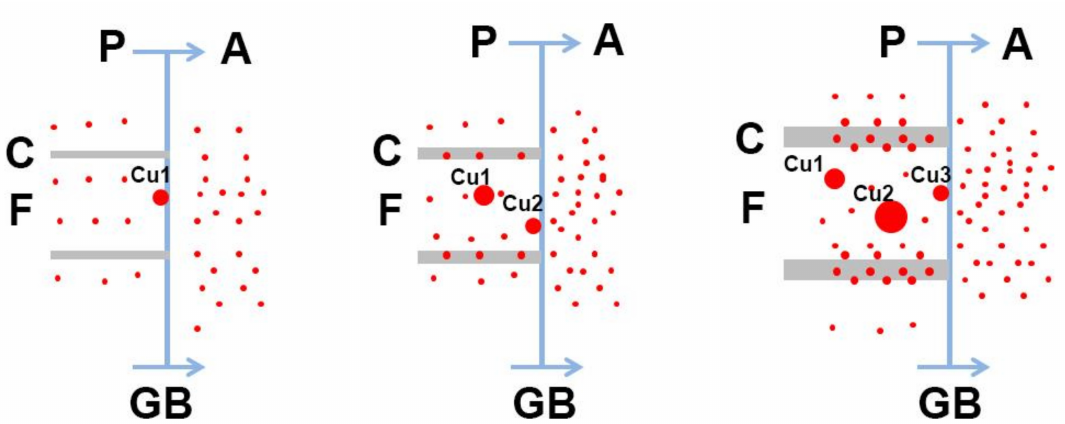
Figure 12. Schematic diagrams of the cooling process showing the copper (red dot), solutes di ff usion, and redistribution process companying the austenite–pearlite transformation and the associated copper precipitation. P: pearlite; F: ferrite; C: cementite; A: austenite; PB: pearlite / austenite phase